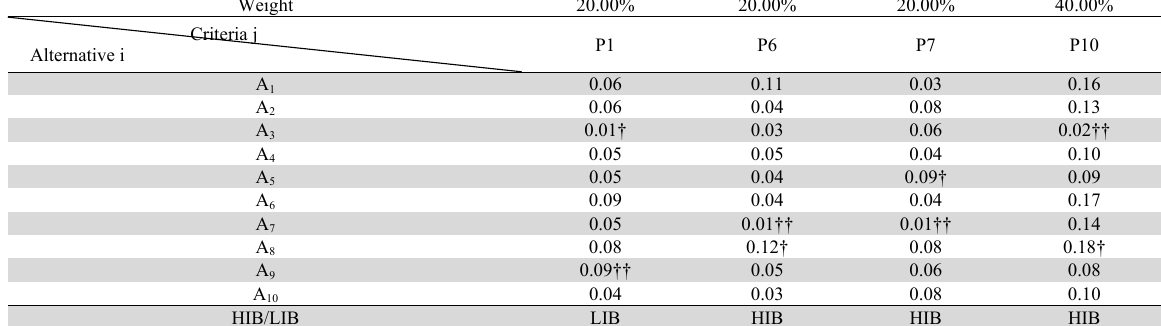
Weighted normalization of